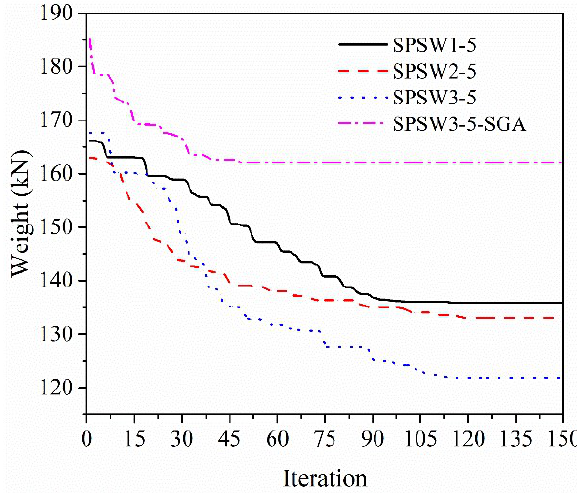
Figure 9. Convergence histories of 5-story steel frame. Table 5 and Figure 9 indicate that the optimum weights of SPSW3-5 were 10.4% and 8.45% lighter than those of SPSW1-5 and SPSW2-5, respectively. The percentages of the story shear resisted by the steel plate are listed in Table 6. The average for SPSW3-5 (59.25%) was higher than that for SPSW1-5 (58.01%) and SPSW2-5 (59.18%); this indicates that the frame weight can be significantly reduced when the average percentage of story shear resisted by the steel plate